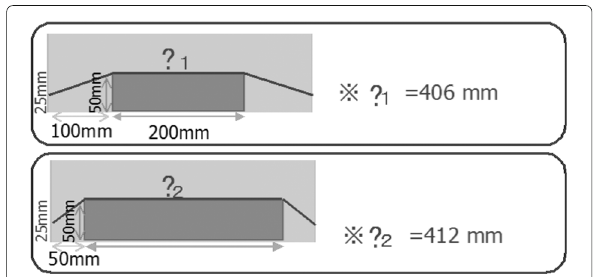
Fig. 5 Propagation of the ultrasonic waves